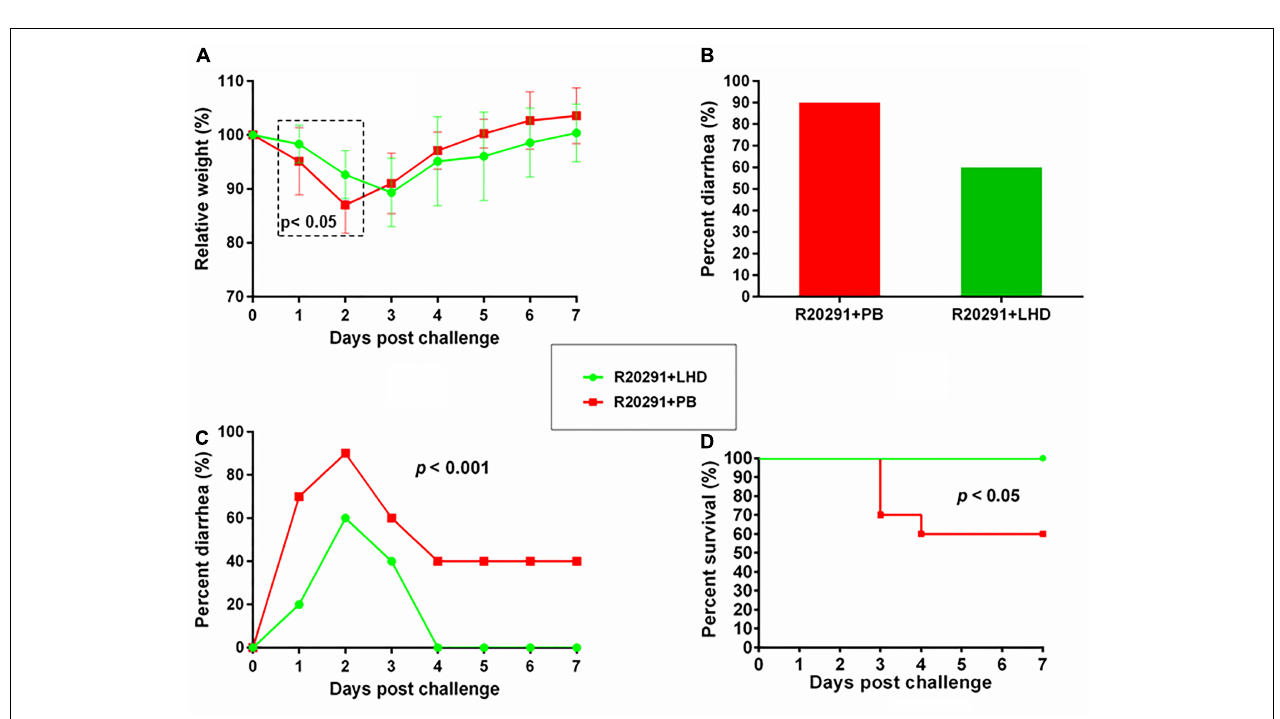
FIGURE 7 | LHD is effective in the treatment of CDI in mice. Twenty BL6/C57 mice were divided into two groups ( n = 10). One group of mice was infected with C. difficile R20291 spores and treated with LHD, and the other group was infected with R20291 spores and treated with PBS as control. The experimental scheme and treatment plan is illustrated in Figure 2 , and described in Methods and Materials. Weight changes (A) , percentage of diarrhea (B , C) , survivals of two group mice (D) were plotted. Mice in group “R20291+LHD” lost significantly less weight in postinfection days 1 and 2 ( p < 0.05, marked in dash box region)